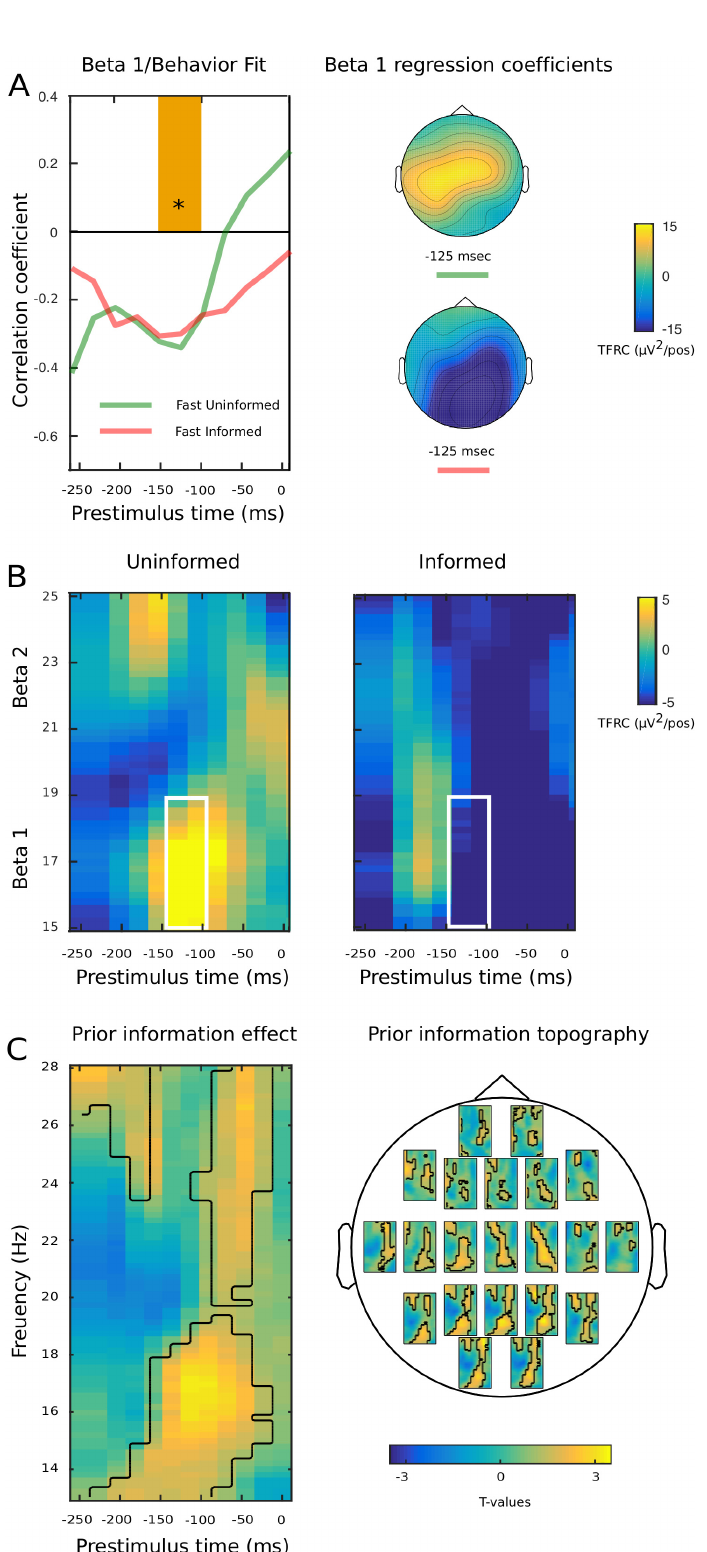
Fig 4. Oscillatory hazard rate in fast sequences. A. Left panel, pre-stimulus Beta 1 (14–19 Hz) oscillatory power (median across all scalp electrodes) significantly predicts response speed to target onset, for both uninformed and informed conditions. Right panel, topography of Time-Frequency Regression Coefficients (TFRCs, measured in μ V 2